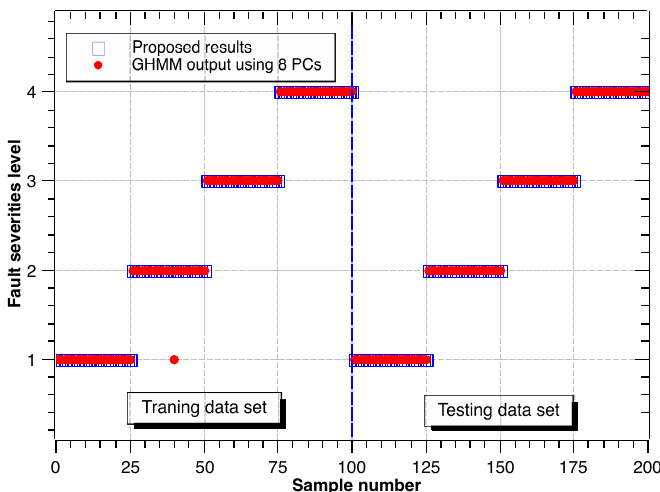
Figure 9. Classification results of fault severity levels under inner race